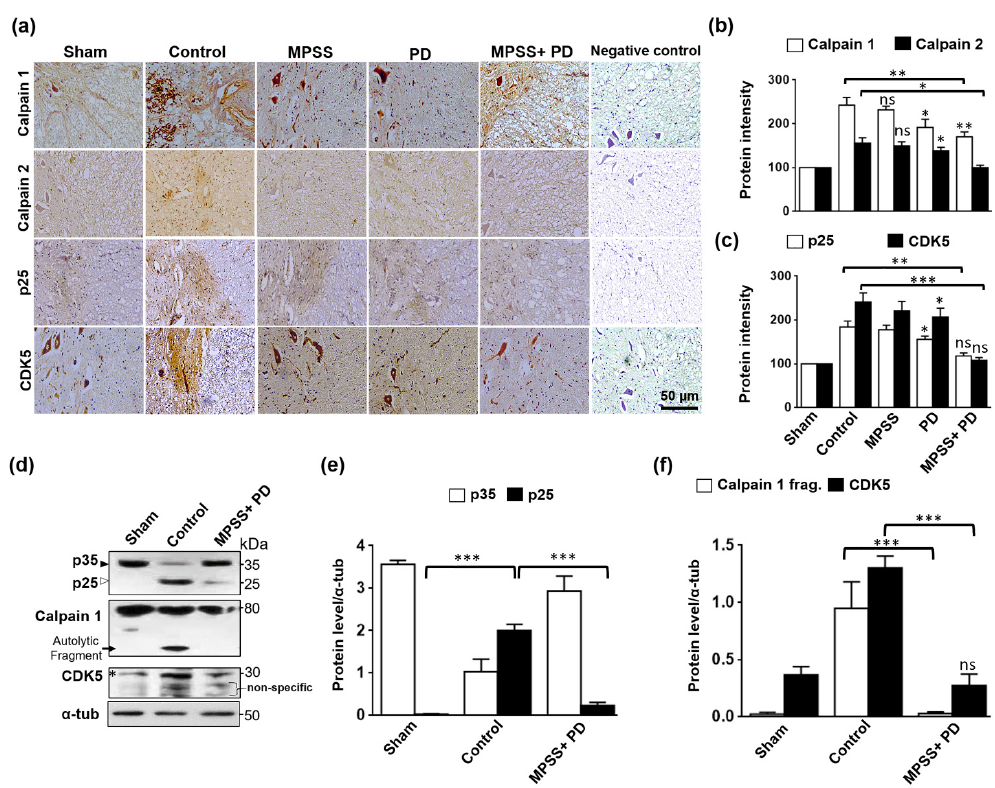
Figure 8. Inhibition of calpain abolishes the generation of p25 and consequently the CDK5 activation. ( a ) Representative images immunoassayed with calpain1, calpain 2, p25, and CDK5 antibodies from the indicated groups. The increased expression of the indicated proteins was not significantly reduced in the MPSS group, but was significantly attenuated in PD150606 and the combination group. Negative control for antibody reaction was used where non-specific secondary antibody was used. ( b ) Quantitative analysis of the average protein intensity of both calpains 1 and 2, while ( c ) intensity of p25 and CDK5 in the indicated groups. Ten images from each group were used for data quantification. Data are presented as the mean ± SD. * p <0.05 and ** p <0.01. ( d ) Immunoblots show proteolytic cleavage of p35 to p25, autolytic fragments of calpain, and CDK5 protein levels in spinal cord lysates from the indicated groups. There was no p35 cleavage and autolytic calpains fragment in the sham group. Truncation p35 to p25 was increased in the spinal cord injury of the control group following SCI. This truncation was remarkably inhibited in the combination group of MPSS+PD150606. The black arrowhead indicates the full length of p35 protein, while the white ar- rowhead indicates the truncated p25 protein. Black arrows indicate the autolytic calpain 1 fragment upon calpain activation. Star indicated the specific band of CDK5 at 30 kDa. α -tubulin was used as a loading control. ( e ) Bar graphs show relative levels of the p35 and p25, and ( f ) calpain 1 fragments and CDK5 protein densities in indicated groups. Data are presented as the mean ± SD ( n = 3). *** p <0.001, and ns indicates non-significant.